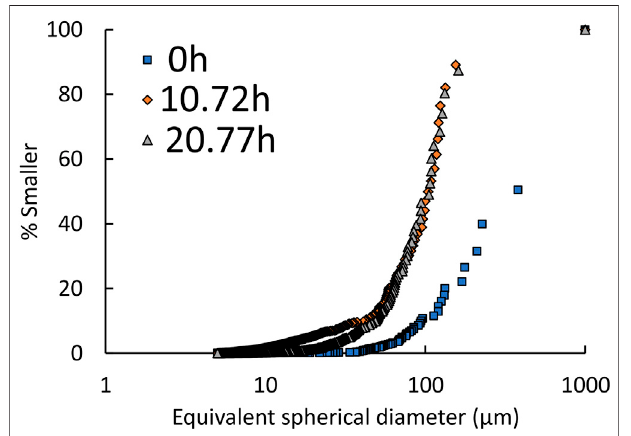
FIGURE5| Evolution ofbubble sizedistributionwithintheporespace of the specimen during the hydrate formation stage.